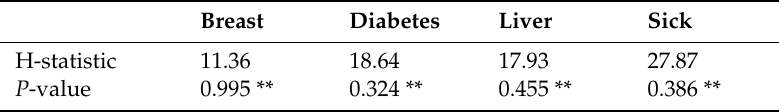
Table 1. Statistics for Kruskall Wallis